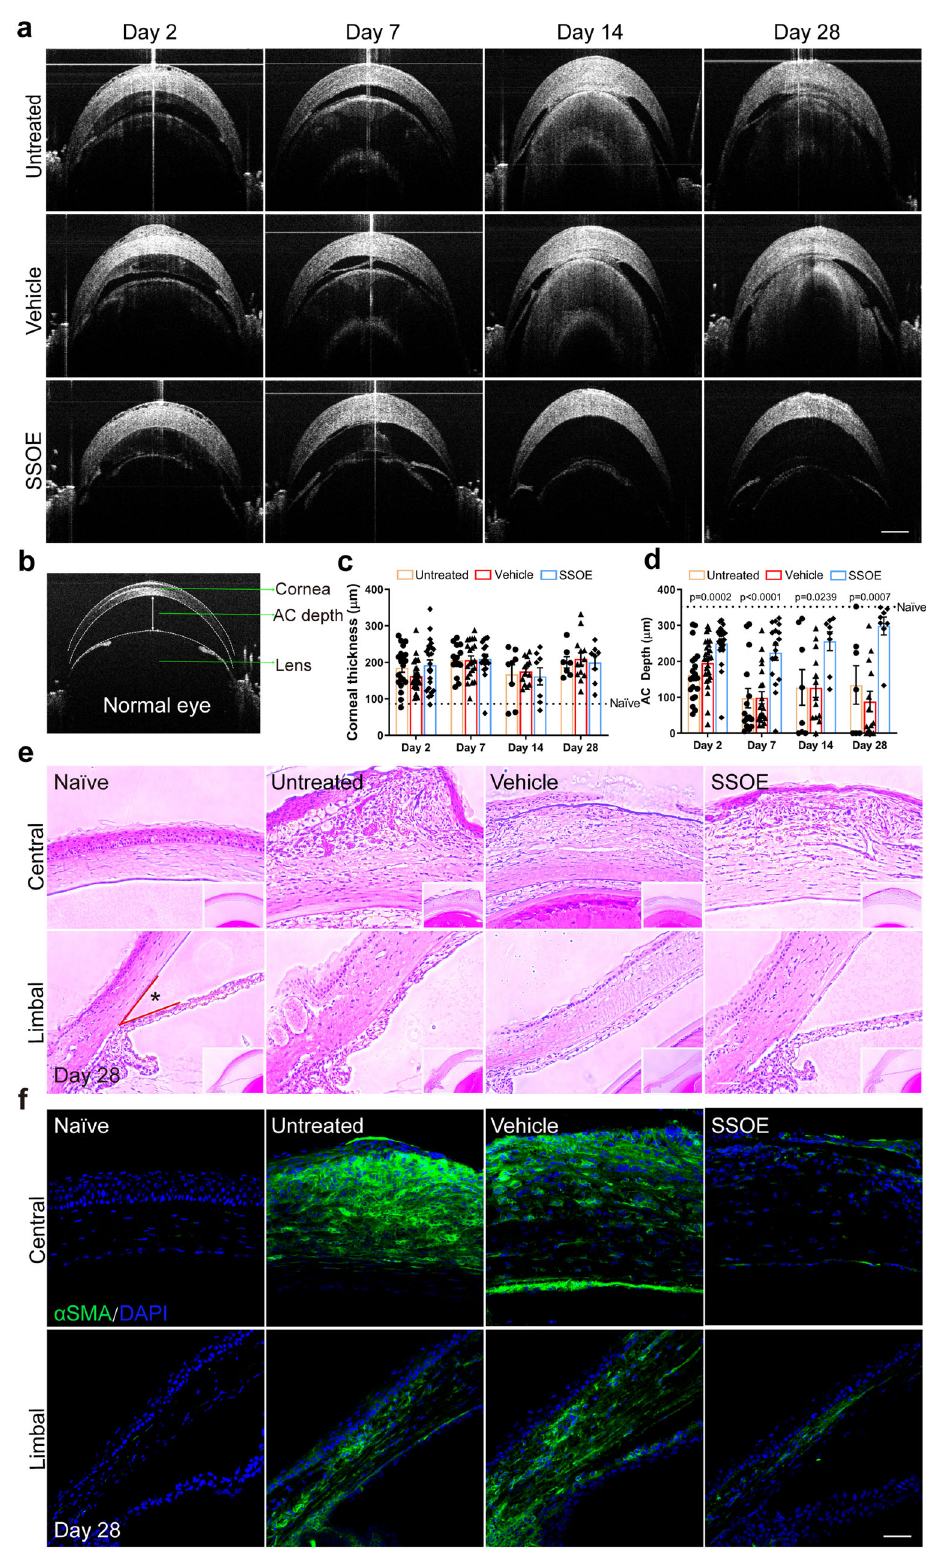
anterior chamber (*Fig. 5e, lower panel), where the corneal endothe- lium and the root of iris meet, is obliterated in untreated and vehicle- treated eyes; whereas it was maintained in the SSOE-treated ones. α -smooth muscle actin ( α SMA), a marker for myo fi broblasts, highlights tissue fi brosis and scar formation. The anterior segment of